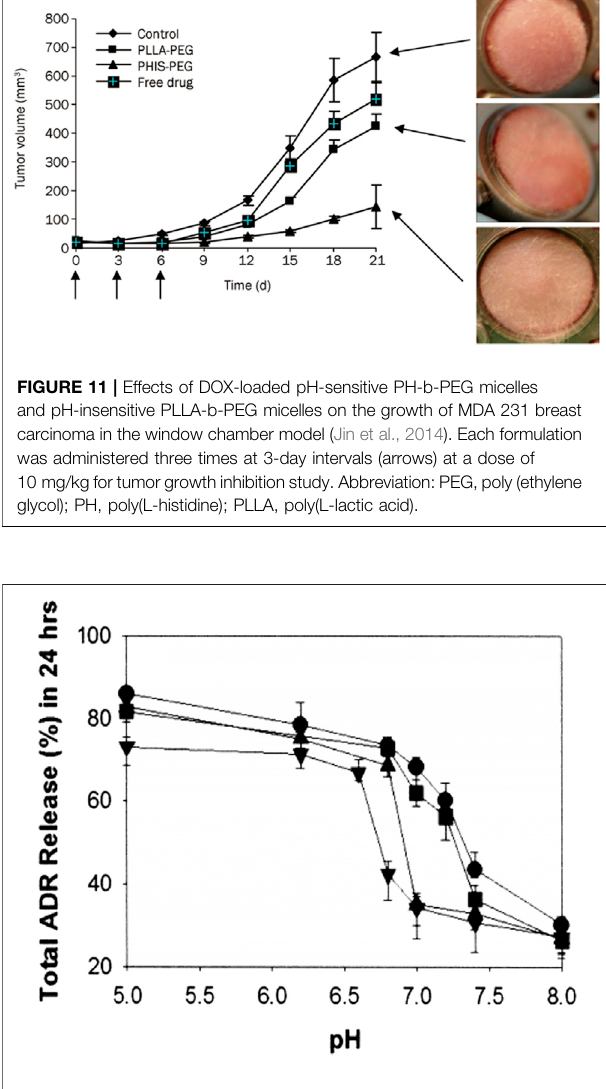
FIGURE 12 | pH-dependent cumulative adriamycin (ADR) release from the mixed micelles composed of polyHis/PEG and PLLA/PEG [PLLA/PEG content in the mixed micelles: 0 wt.% ( C ), 10 wt.% ( ■ ), 25 wt.% ( ▲ ), and 40 wt.% ( ▼ )] (Lee E. et al.,